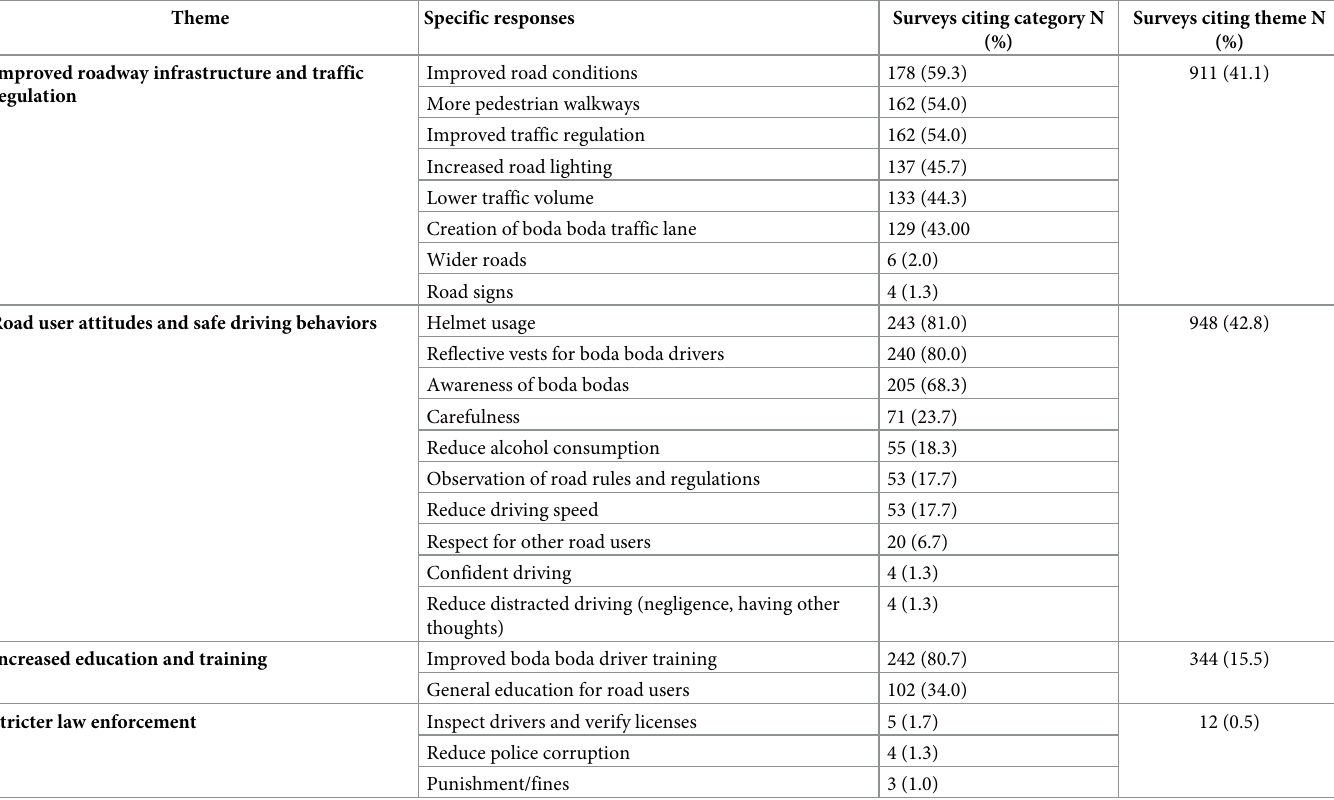
Table 3. Thematic analysis of boda boda driver short answer